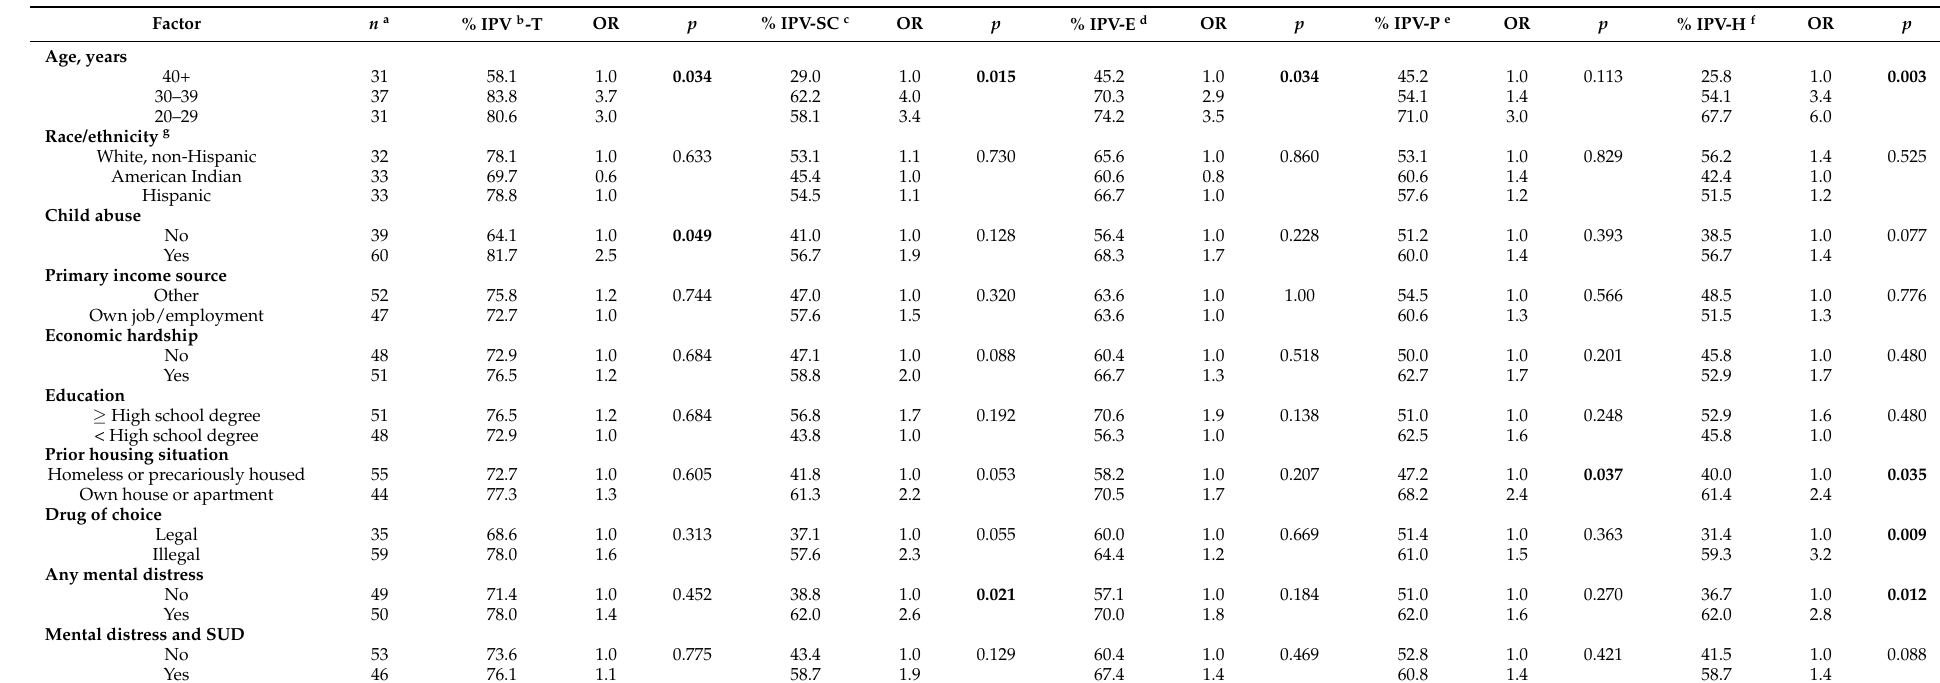
Table 3. Univariate analyses of IPV by